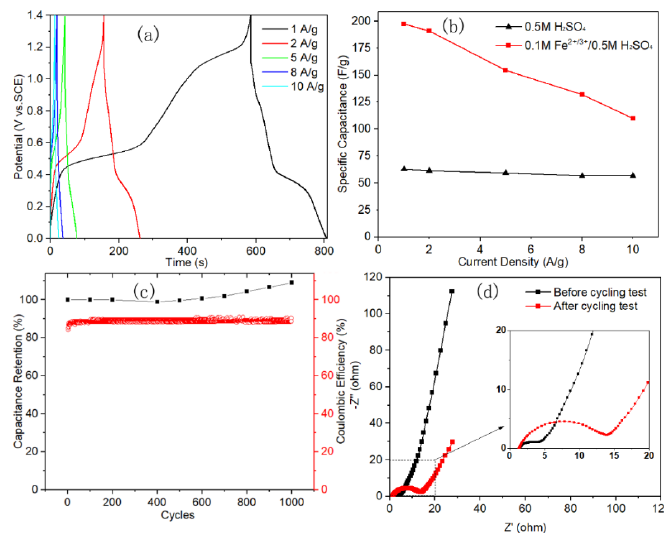
Figure 5. ( a ) GCD curves of ASC at different current densities; ( b ) specific capacitance of ASC in different electrolytes; ( c ) capacitance retention and the columbic efficiency of 1000 cyclic test; and, ( d ) electrochemical impedance spectroscopy (EIS) spectra before and after cycling test. Table 1. Performance of MoO 3 single electrode and ASCs assembled with MoO 3 electrode.